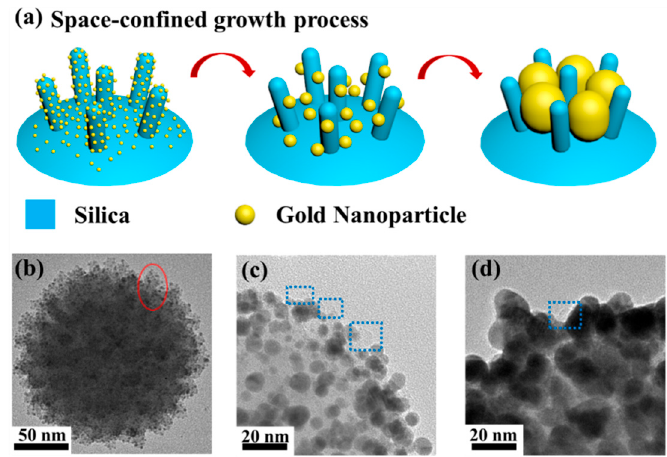
Figure 4. ( a ) A schematic diagram illustrating the formation mechanism of the AuNRb structure. ( b ) The TEM image of a single AuNC. The red ellipse highlights a spike covered with gold nanoseeds. ( c ) The close-up TEM image of a AuNRb-8. Inside the dotted blue boxes are the silica spikes. ( d ) The close-up TEM image of a AuNRb-15. Inside the dotted blue box is a silica